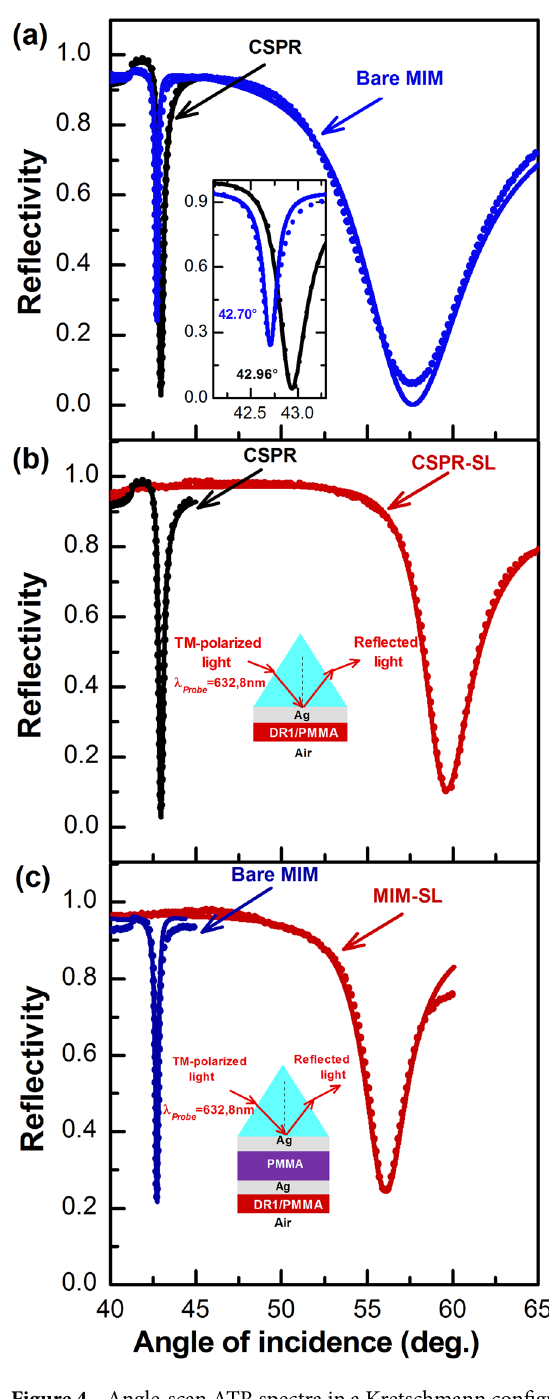
Figure 4. Angle-scan ATR spectra in a Kretschmann configuration for CSPR and MIM. ( a ) Both CSPR and MIM, sharp and broad, modes without the SL. ( b ) CSPR and ( c ) MIM, with and without the DR1/PMMA sensing layer. The dots are experimental data and the solid lines are theoretical Fresnel fits. The inset in ( a ) is an expanded view of the resonance region of the CSPR and Sharp MIM mode, and in ( b , c ) are the schematics of the CSPR and MIM structures;